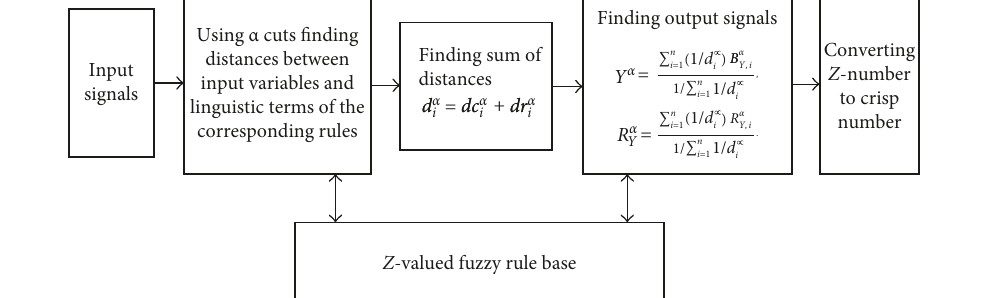
Figure 4: Architecture of the Z- number-based